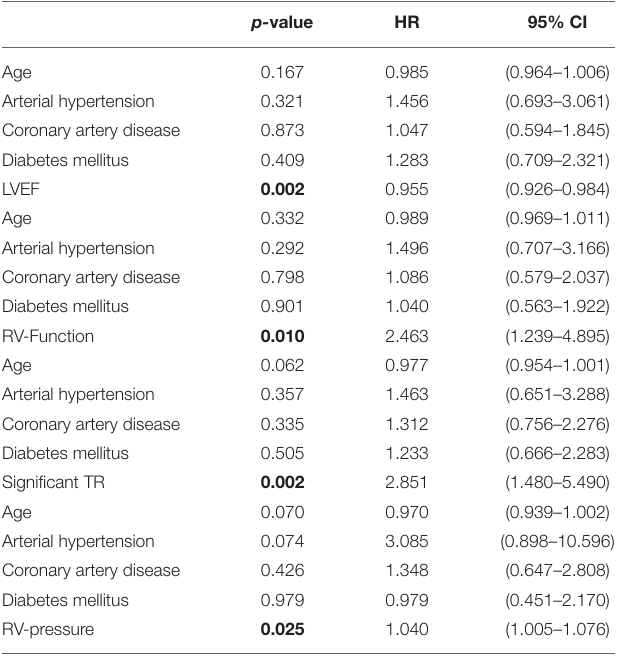
TABLE 3 | Cox regression with markers of myocardial function as well as epidemiological factors as independent variables and the combined endpoint as dependent